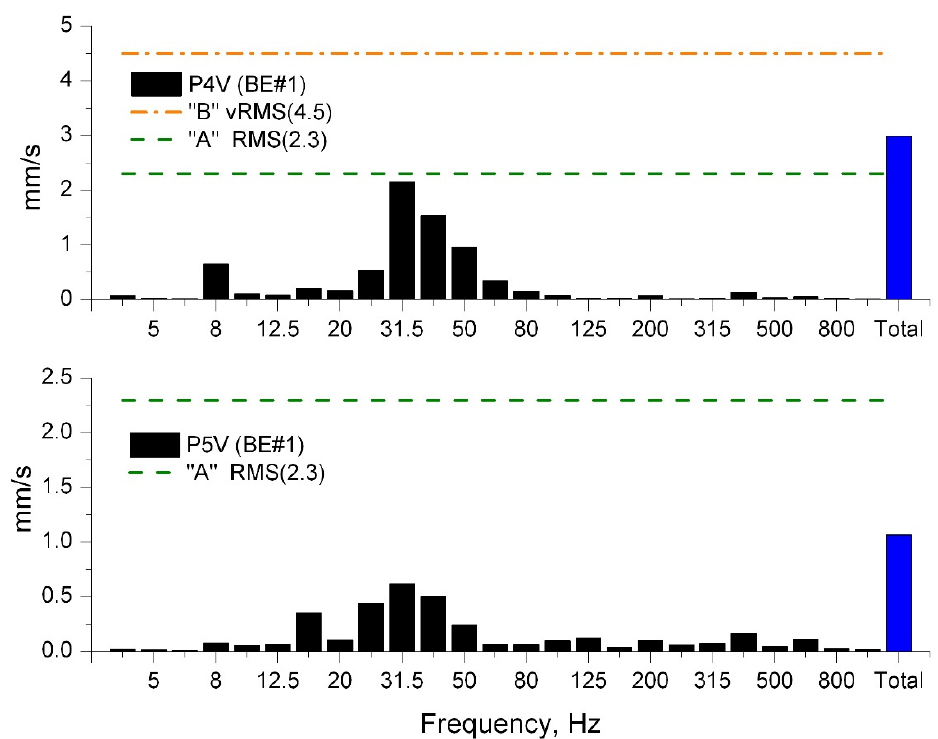
Figure 10. Typical spectrum of the RMS vibration velocity in the vertical direction at points P4 ( top ) and P5 ( bottom ) on the output shaft in bucket elevator BE#1. The column with the total value is marked in blue.